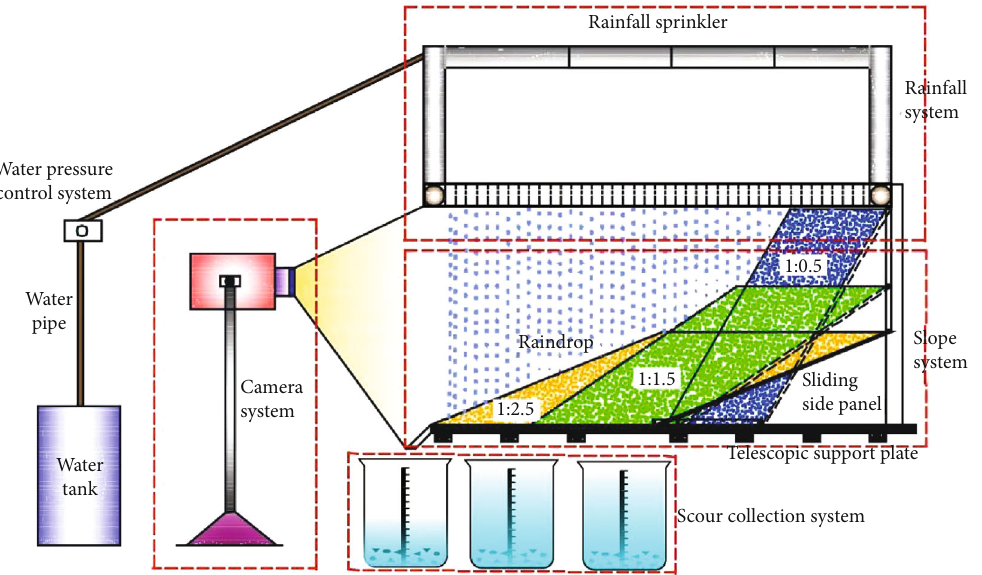
Figure 5: Schematic diagram of the test